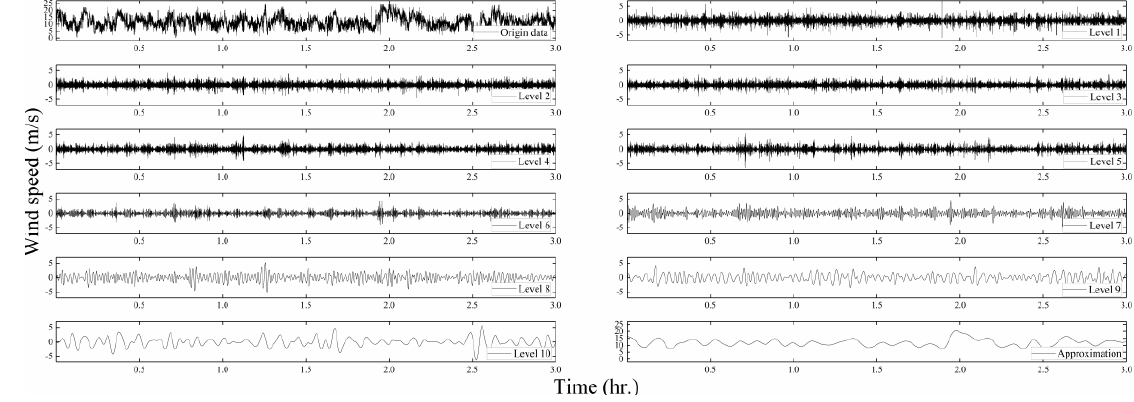
Figure 5. Wavelet-matrix transform (WMT) decomposition of the Lekima data.